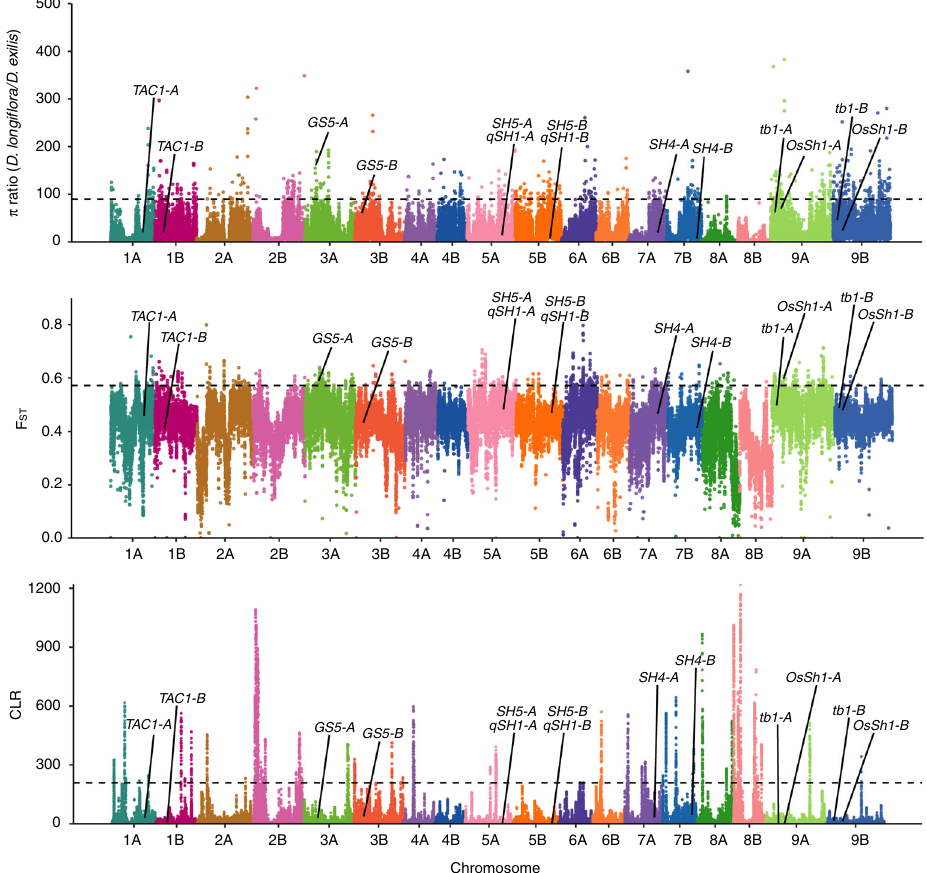
Fig. 4 Detection of selection in fonio. Manhattan plots showing detection of selection along the genome based on nucleotide diversity ( π ) ratio, F ST and SweeD (from top to bottom). The location of orthologous genes of major seed shattering and plant architecture genes are indicated in the Manhattan plots. The black dashed lines indicate the 1% threshold. Some extreme outliers in the π ratio plot are not